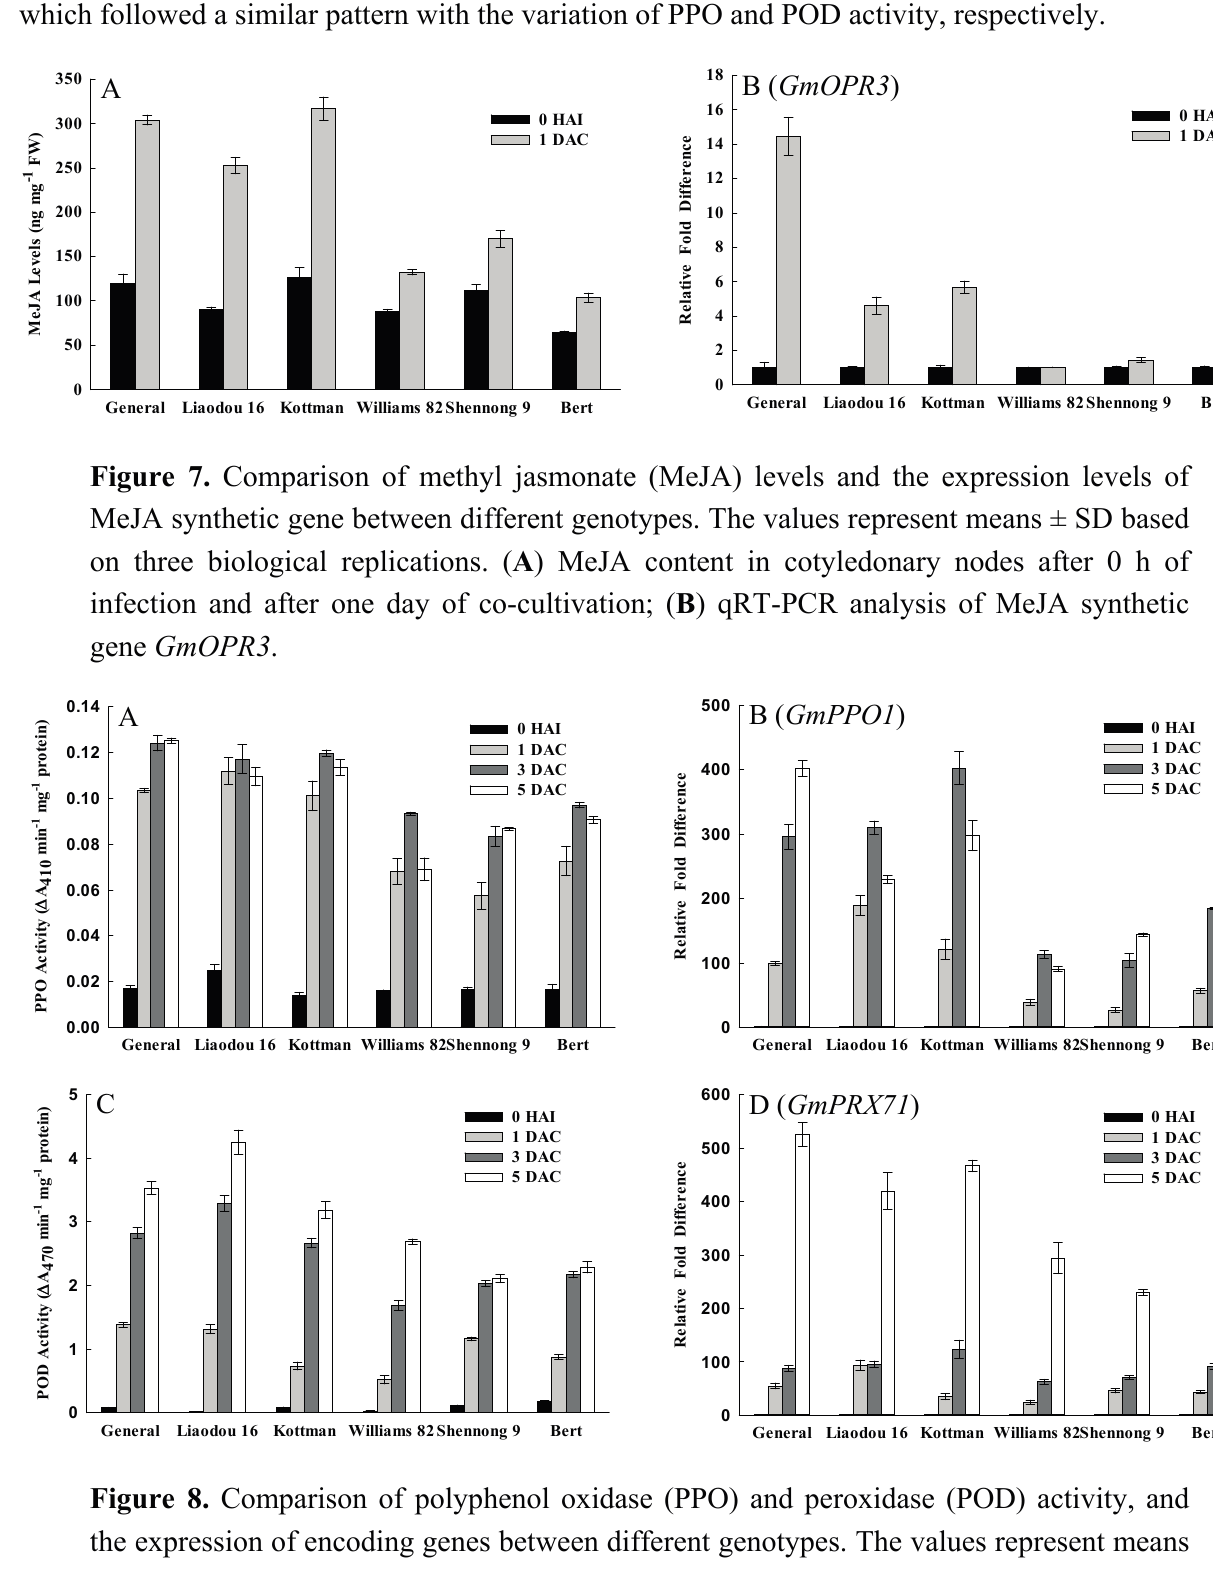
of PPO1 and PRX71 increased more significantly in General, Liaodou 16 and Kottman (Figure 8B,D), which followed a similar pattern with the variation of PPO and POD activity, respectively.